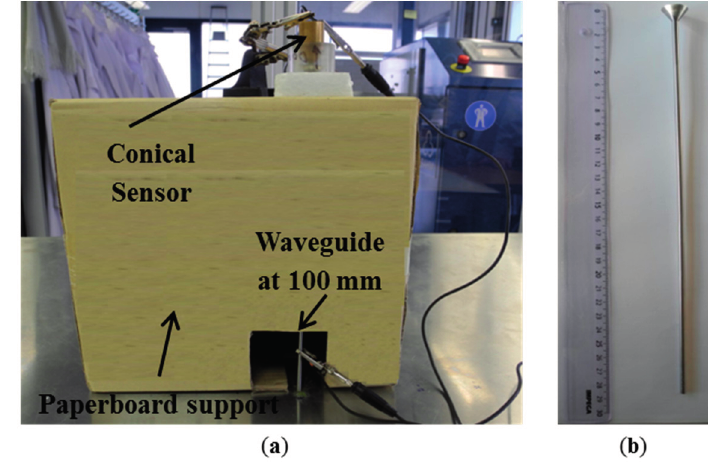
Figure 5. Photography of the experimental setup of ( a ) plate and waveguide and ( b ) photography of the conical